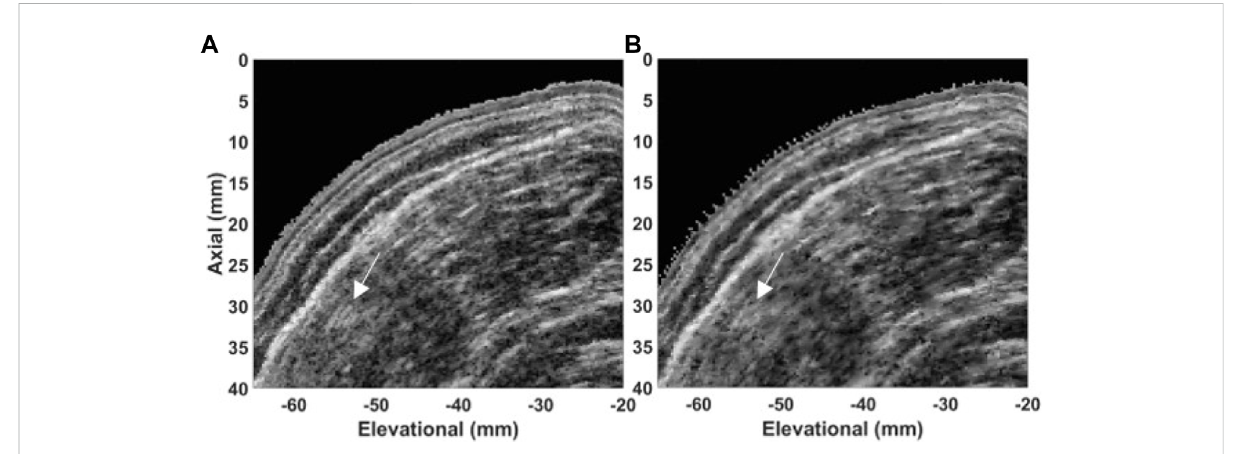
FIGURE 11 In-vivo 3D US data of a tibialis anterior acquired with a radial sweep. Cross-sectional image in transversal plane of the data acquired at (A) 200 fps and (B) 33.3 fps. The examples of differences between the images are indicated with white